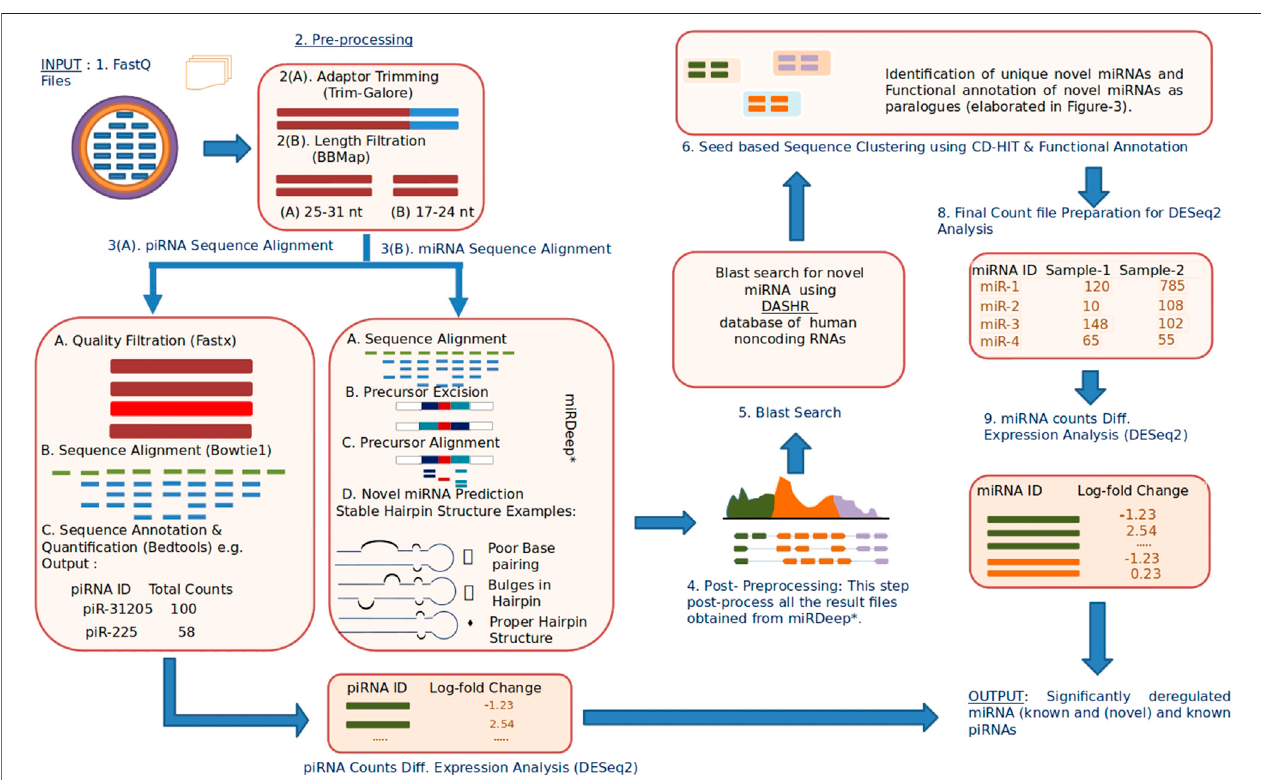
FIGURE2| InfographicrepresentationofmiRPipework fl ow:Thispipelineidenti fi esdifferentiallyexpressednovelmiRNAs,knownmiRNAs,andknownpiRNAs.The RNA-Seq data in standard FASTQ format is cleaned for adaptor contamination. Reads of speci fi c lengths are aligned to the human reference genome for miRNA and piRNA identi fi cation. Further, the aligned reads are processed using novel seed-based clustering for their functional annotation. Lastly, their differential expression analysis is computed using DESeq2 to fi nd the signi fi cantly dysregulated miRNAs and